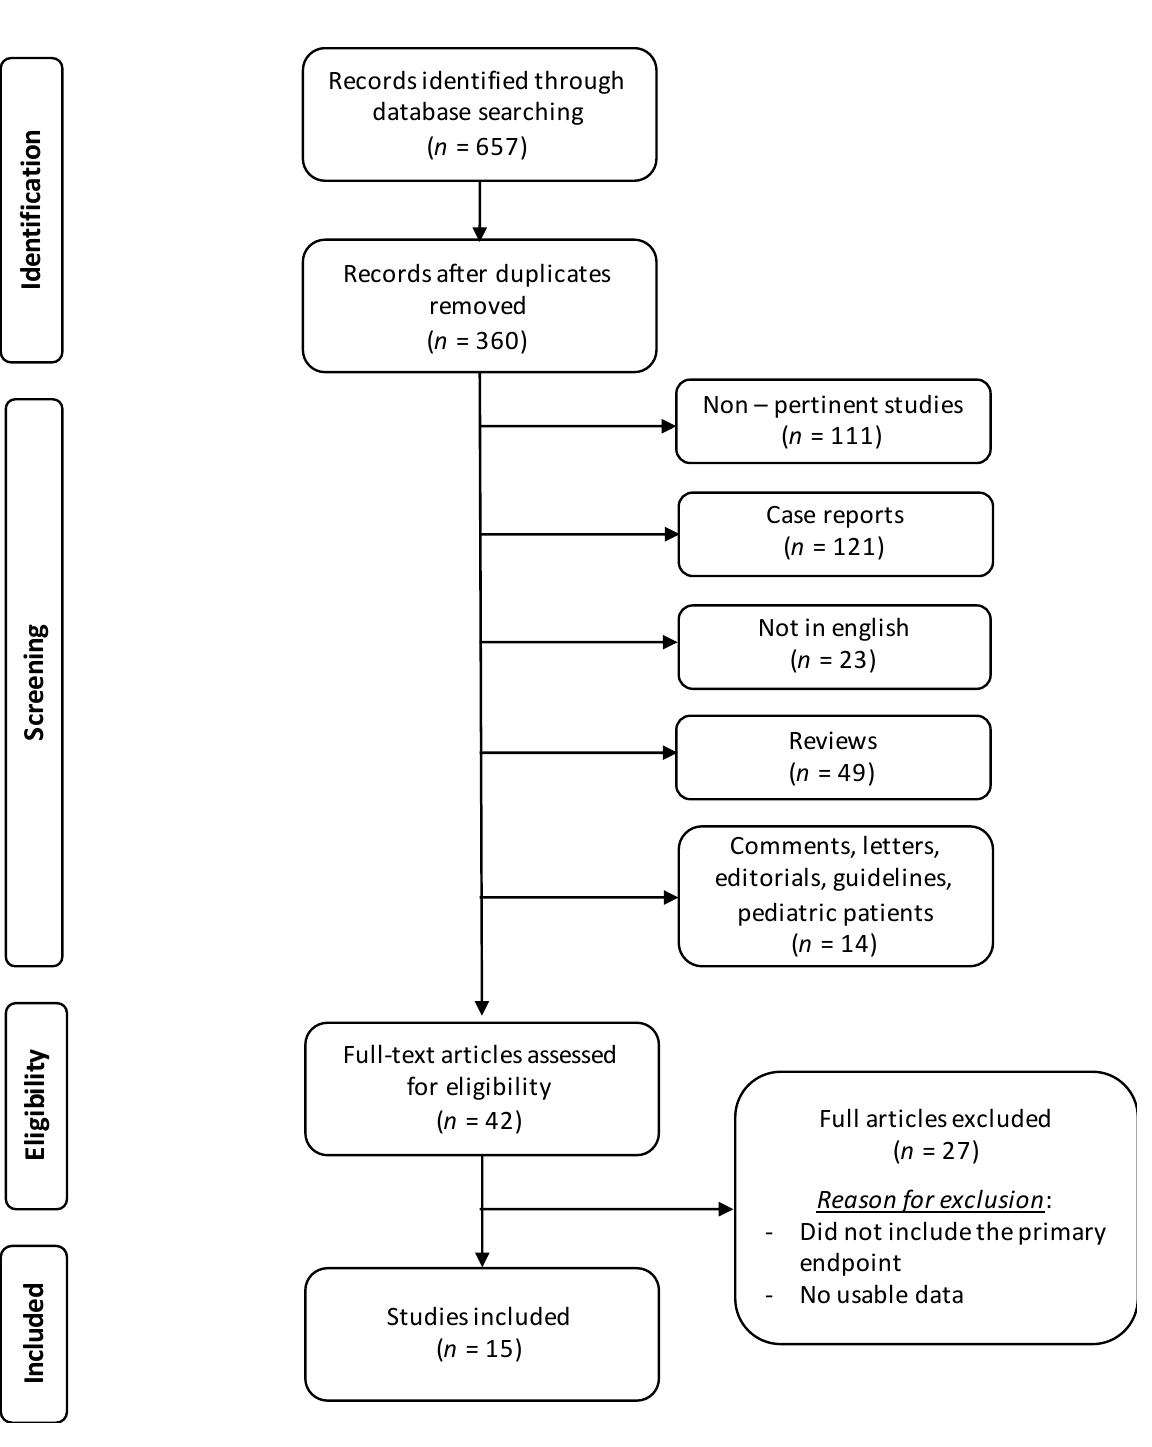
Figure 1. Literature search flowchart.